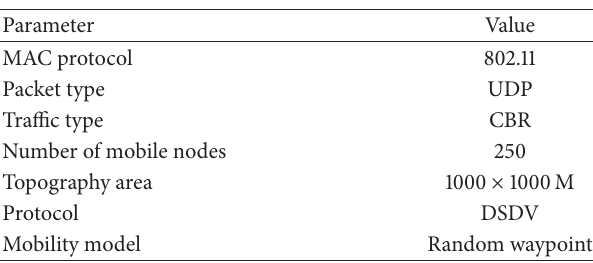
Table 1: Simulation parameters.